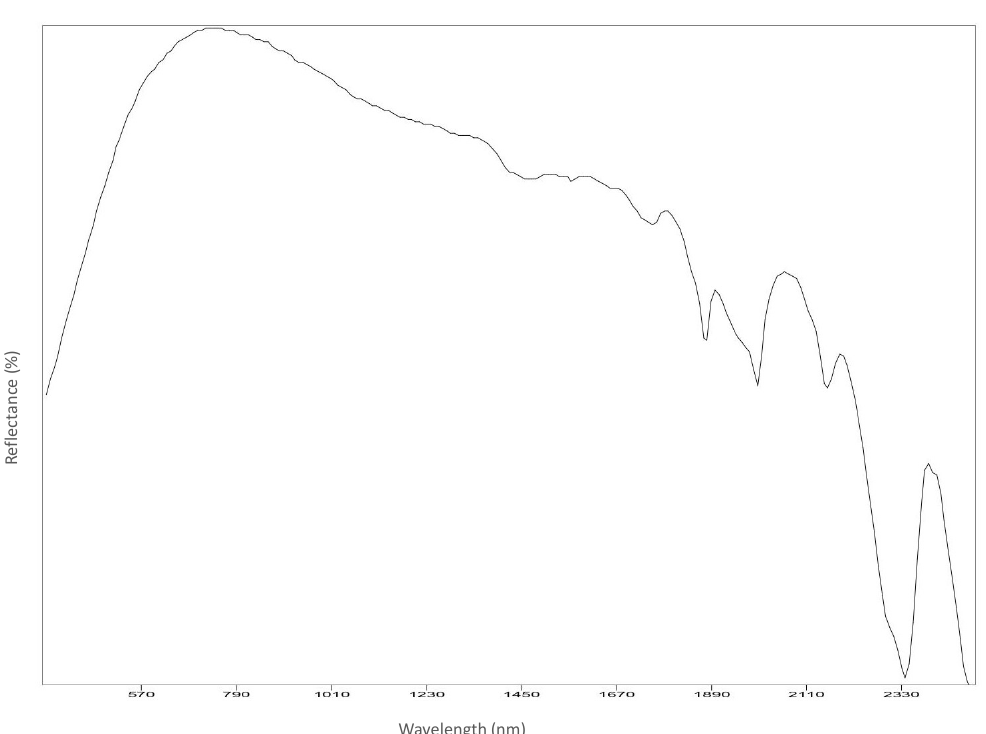
Figure A13. Chin.